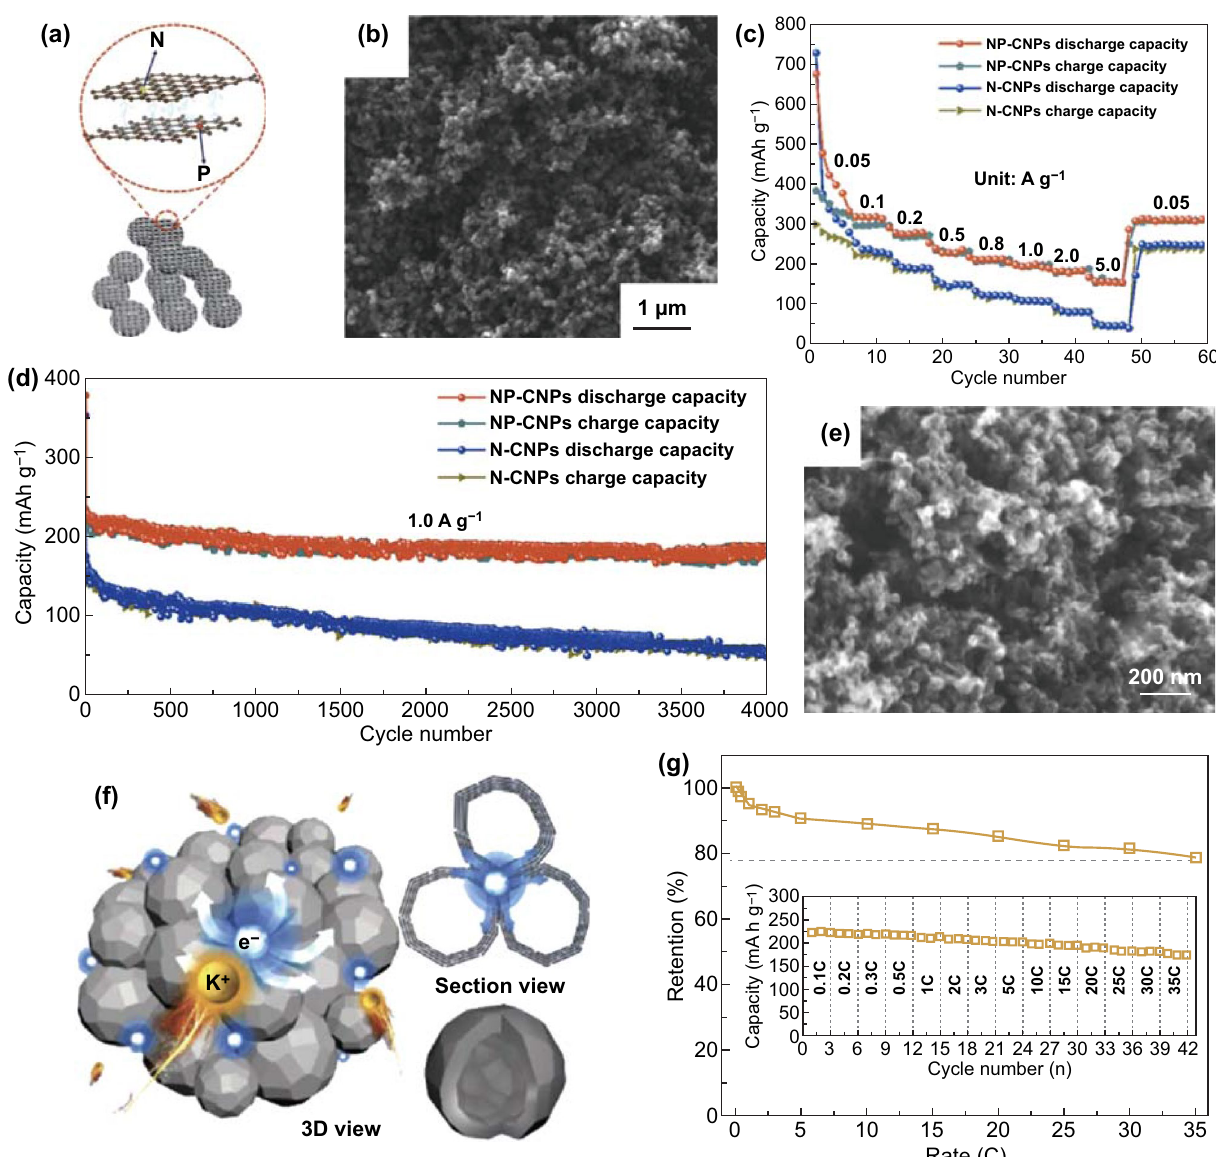
Fig. 3 NP-CNPs’ a schematic diagram, b SEM image, c as well as N–CNPs’ rate capacities in the range of 0.05–5.0 A g −1 , d long cycle capaci- ties at 1.0 A g −1 over 4000 cycles. Reproduced with permission from Ref. [107]. Copyright 2019, American Chemical Society. e SEM image of CNC. f Schematic illustration of CNC. g Discharge capability retention corresponding to rate performance (inset). Reproduced with permission from Ref. [42]. Copyright 2018, John Wiley and